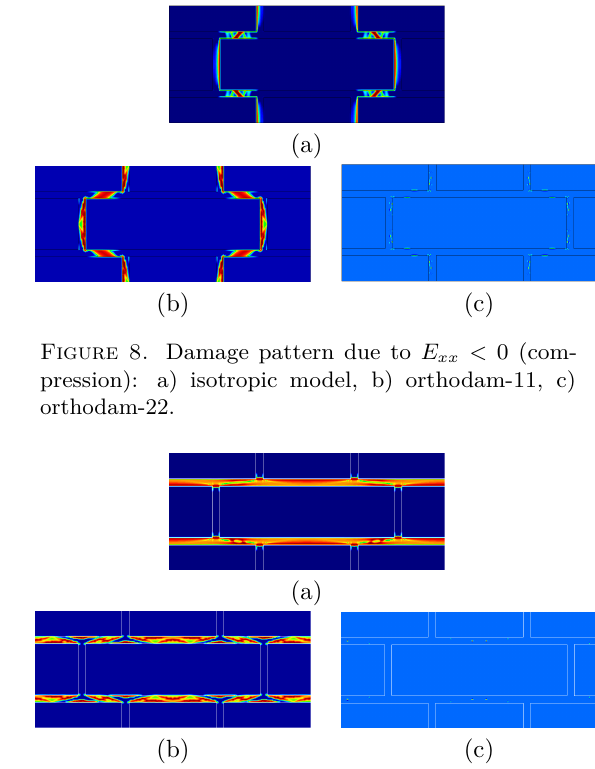
Figure 9. Damage pattern due to E pression): a) isotropic model, b) orthodam-11, c) orthodam-22.